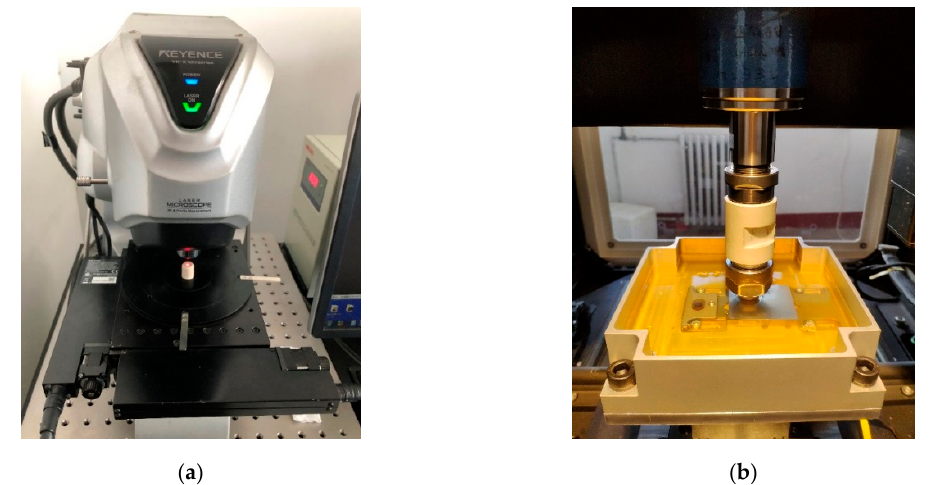
Figure 3. Diagram of testing machine ( a ) Surface topography measurement system (VR-5000, Keyence, Osaka, Japan); ( b ) friction testing machine (Multi Function Tribometer MFT-5000, Rtec Instrument